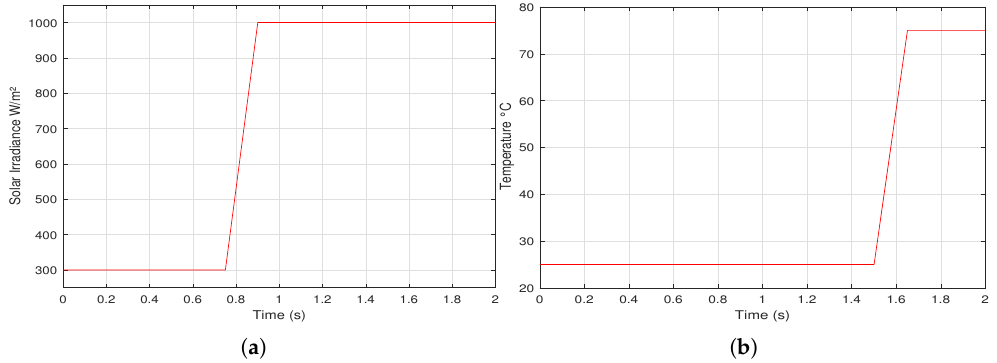
Figure 9. A proposed linear variation of: ( a ) solar irradiance ( b ) cell